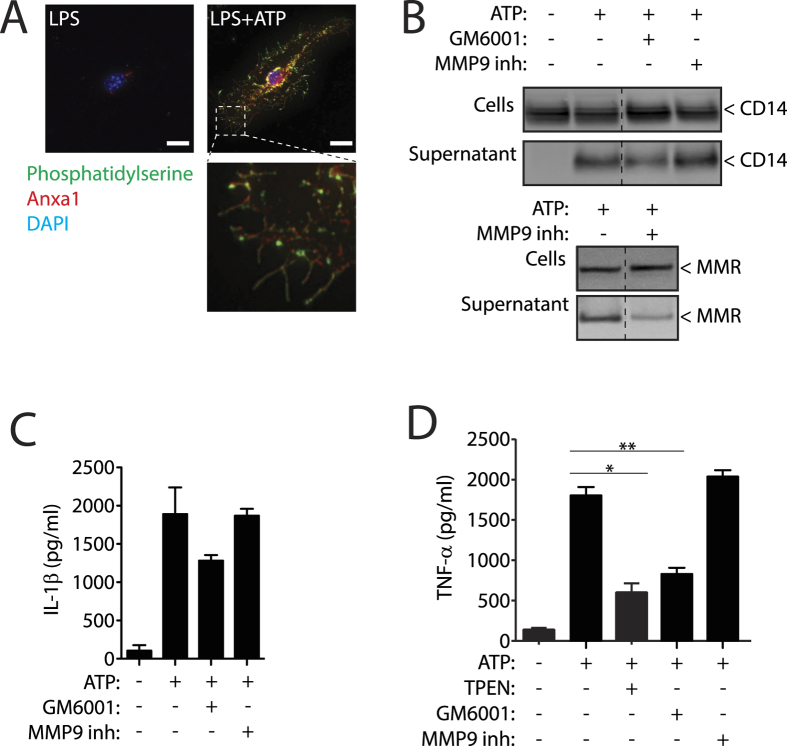
P2X7R controls different mechanisms in Anxa1, CD14, MMR and TNF-α release.(A) Representative high intensity projection deconvolved image of a mouse bone marrow-derived macrophages (BMDMs) primed for 4 h with LPS (1 μg/ml), followed by stimulation or not for 5 min with ATP (3 mM) and stained for phosphatidylserine with annexin V-FITC (green), for anxa1 (red) and for nuclei (DAPI, blue) without cell permeabilization; scale bar = 10 μM. (B) Western blot for CD14 and MMR in cell-free supernatants and cell lysates from BMDM primed as in (A) but with 20 min of ATP (3 mM) stimulation; 10 min before and during ATP stimulation cells were incubated with the general metalloprotease inhibitor GM6001 (100 nM) or with the specific MMP9 inhibitor I (100 nM). Western blots are representative of n = 2 independent experiments and composite is from lanes of the same membrane. (C,D) ELISA analysis for released IL-1β (C) or TNF-α (D) from BMDMs treated as in (B) and additionally 10 min before and during ATP stimulation cells were incubated with the Zn2+ chelator TPEN (50 μM). Data is presented as mean and s.e.m. of n = 3 independent experiments.